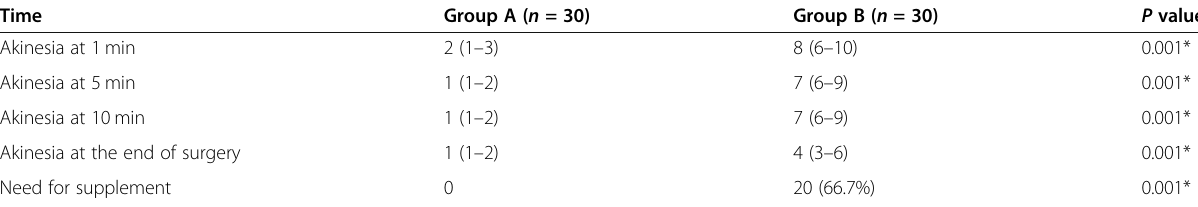
Table 6 Comparison between group A and B as regards Akinesia score Time Akinesia at 1